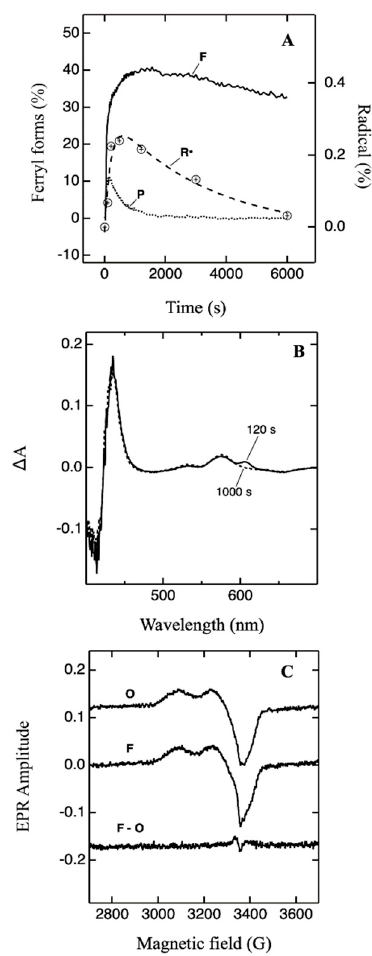
Figure 5. Production and decay of ferryl intermediates and the radical registered by visible absorption and EPR spectroscopies. ( A ) Kinetics of the generation and the endogenous decay of the F • (F, full line), the P M (P, dotted line), and the radical (R • , dashed line) observed during the reaction of 98 µ M oxidized CcO with 98 µ M H 2 O 2 at pH 5.7 and 5 ◦ C. ( B ) The difference spectra of peroxide-treated CcO collected at 120 s (full line) and 1000 s (dashed line) after the injection of H 2 O 2 vs. initial oxidized CcO. ( C ) The corresponding EPR spectra of initial oxidized CcO ( O ), the peroxide-treated CcO at 1200 s ( F ), and the difference between these two spectra ( F - O ). The spectra were collected at 80 K using a power of 0.2 mW (for details see Materials and Methods). The amount of ferryl intermediates and the radical is expressed relative to the total concentration of CcO. Buffer: 101 mM KPi, 30 mM K 2 SO 4 , 0.6% DM and 260 units/mL SOD. Table 1. Time constants ( τ ) of the generation of ferryl intermediates and the free radical during the reaction of the oxidized CcO (98 µ M) with hydrogen peroxide (98 µ M) at pH 5.7 and 5 ◦ C. the slow phase (Table 1).